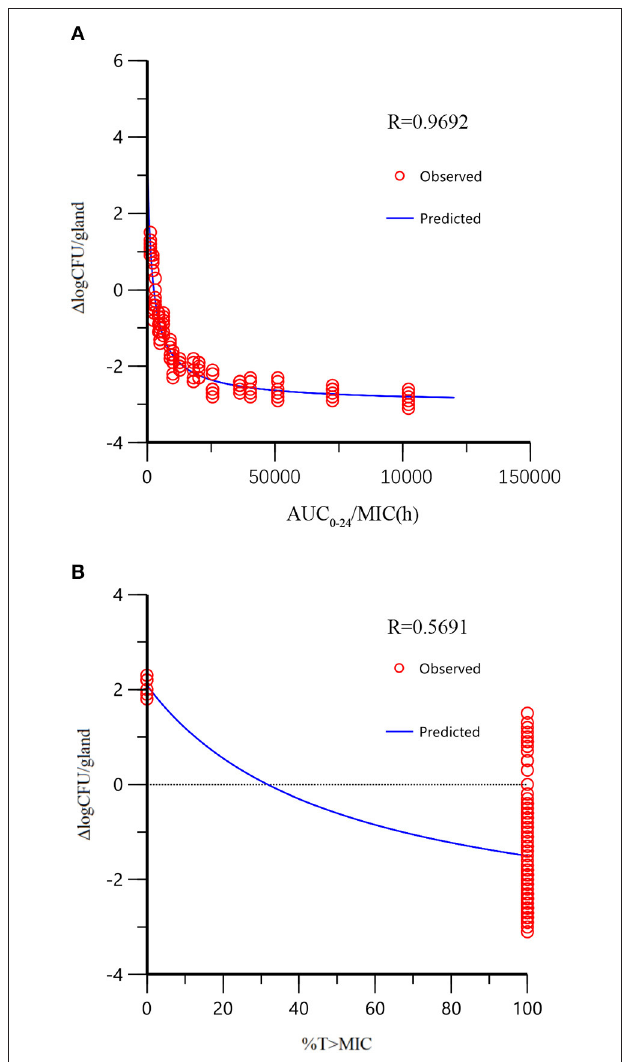
FIGURE 4 | The relationship between PK/PD parameters and bactericidal effect of rifaximin ( 1 log 10 CFU/gland) analyzed by the sigmoid model. The dots represented the antibacterial effect of rifaximin ( E = final log 10 CFU/gland – initial log l0 CFU/gland) and the line represented the predicted value of E . The correlation of %T > MIC with 1 log 10 CFU/gland was very low because of the distribution of %T > MIC (either 100 or 0%), which was not appropriate for PK/PD integration (there are only two independent values, so R 2 has no meaning for %T > MIC).